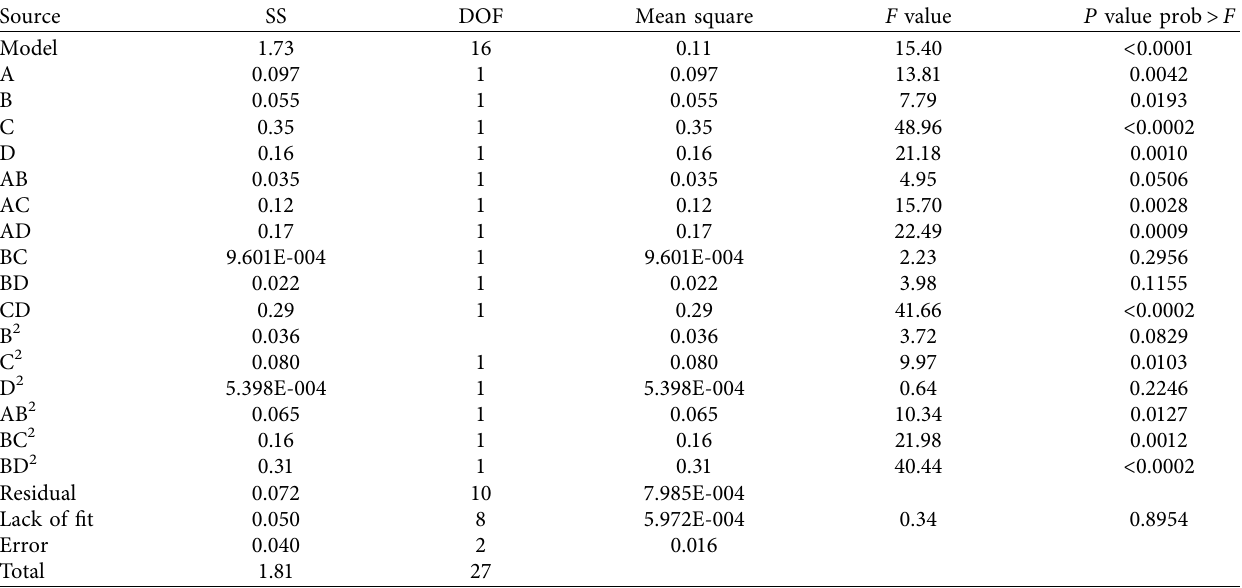
Table 6: Surface roughness (Ra) ANOVA result.